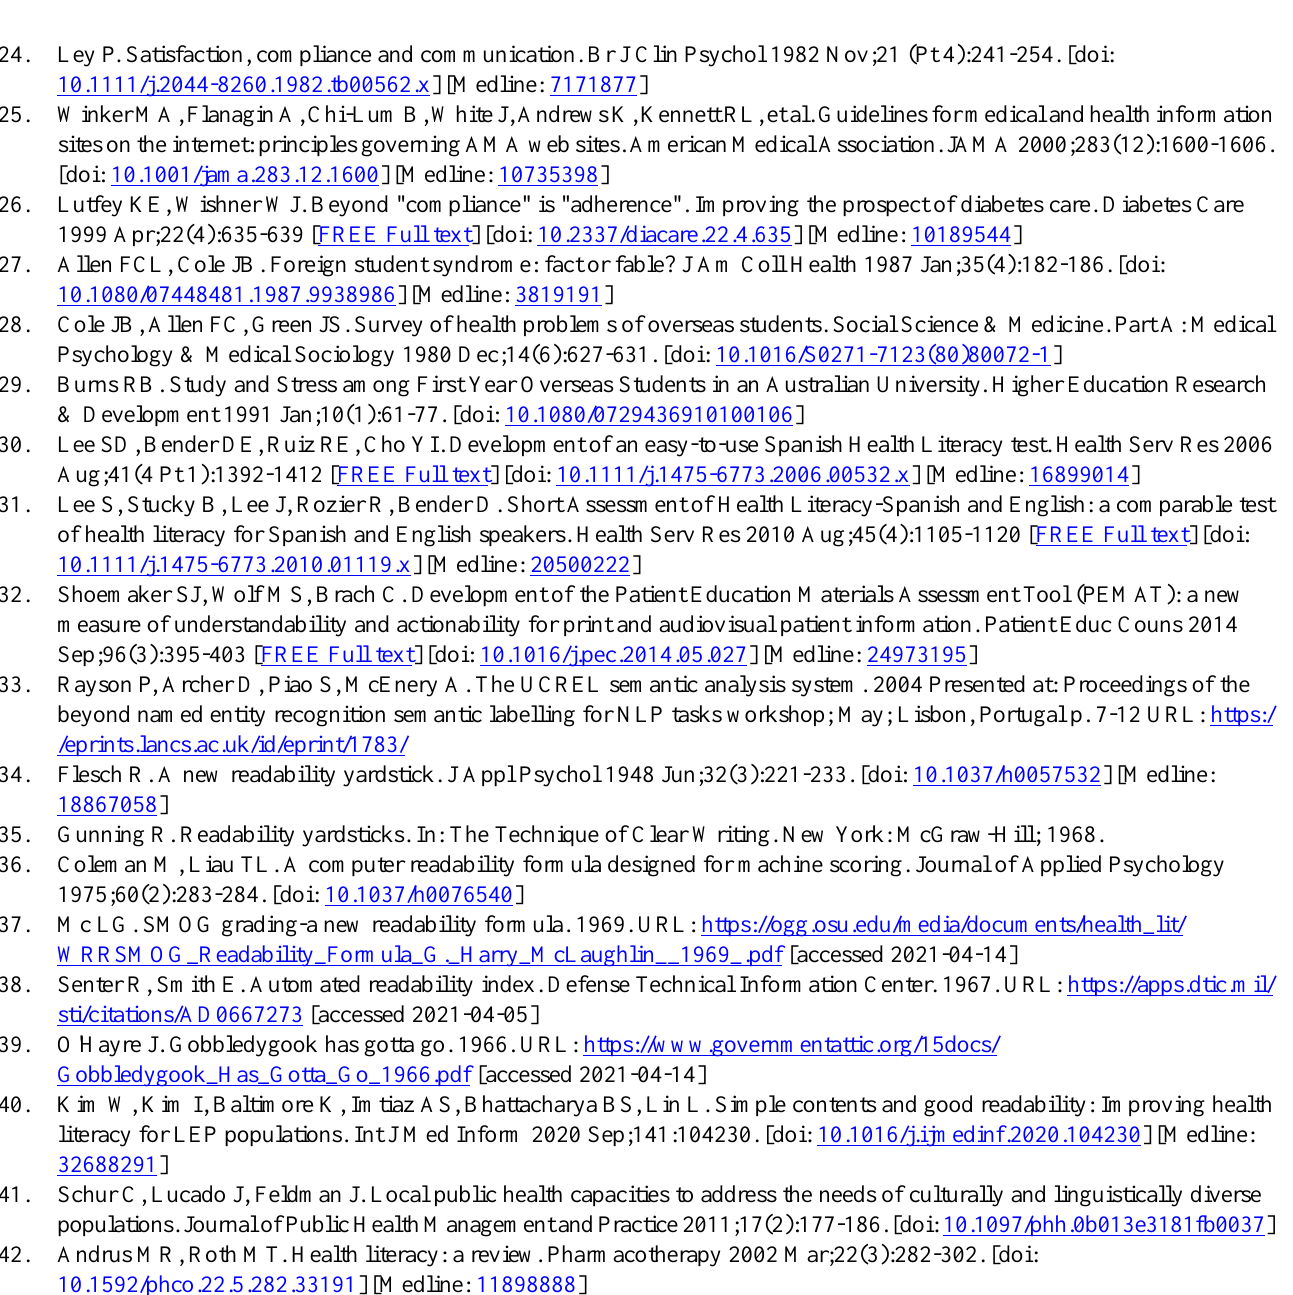
Abbreviations AUC: area under the receiver operating characteristic curve PEMAT: Patient Education Materials Assessment Tool USAS: UCREL English Semantic Analysis System XGBoost: extreme gradient